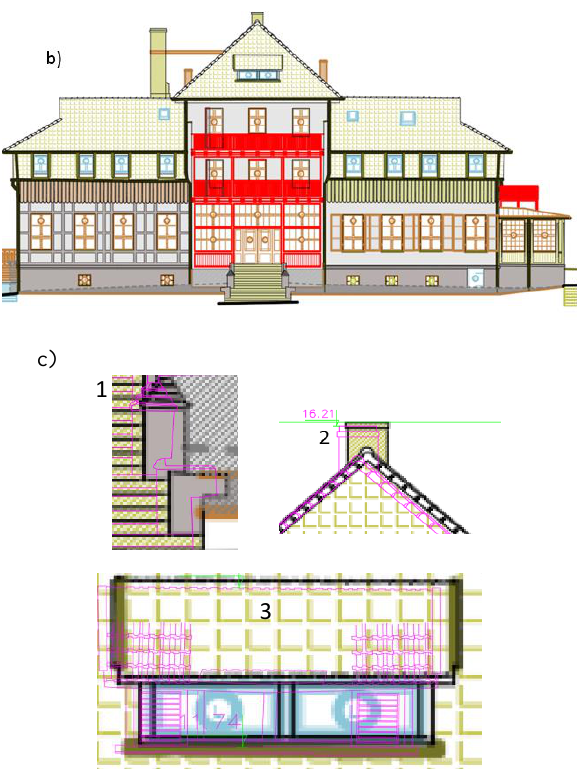
Figure 6. Western façade of the building: a) surveyors 2D model; b) architects 2D model; c) deviations between two models: 1) columns and treads of stairs; 2) chimney and roof; 3) windows of attic.